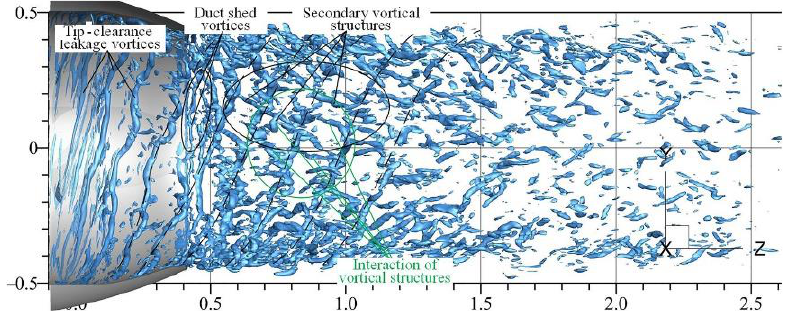
Figure 14. Vortices in the bound of the mainstream [15].